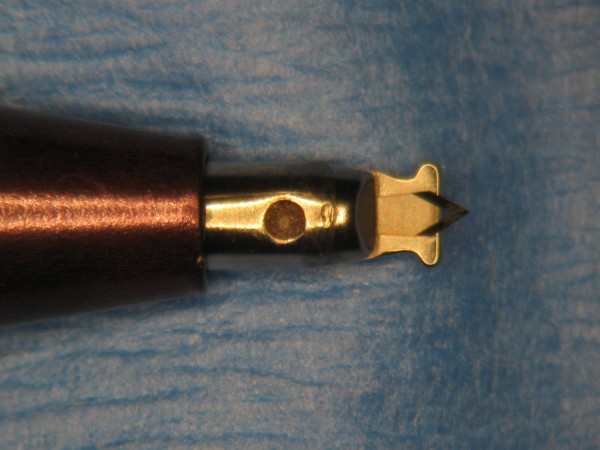
Accutome Rubenstein LRI knife.